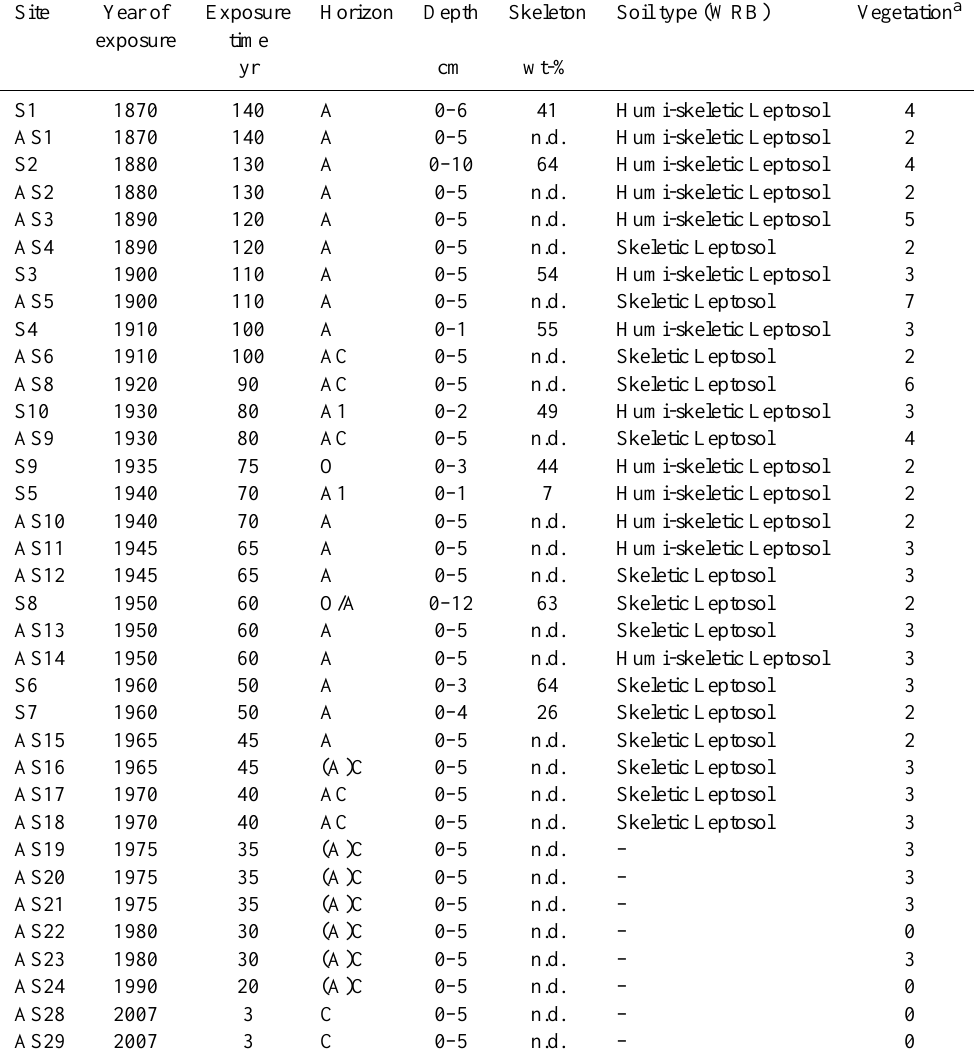
Table 1. General properties of the investigated sites in the Morteratsch proglacial area.